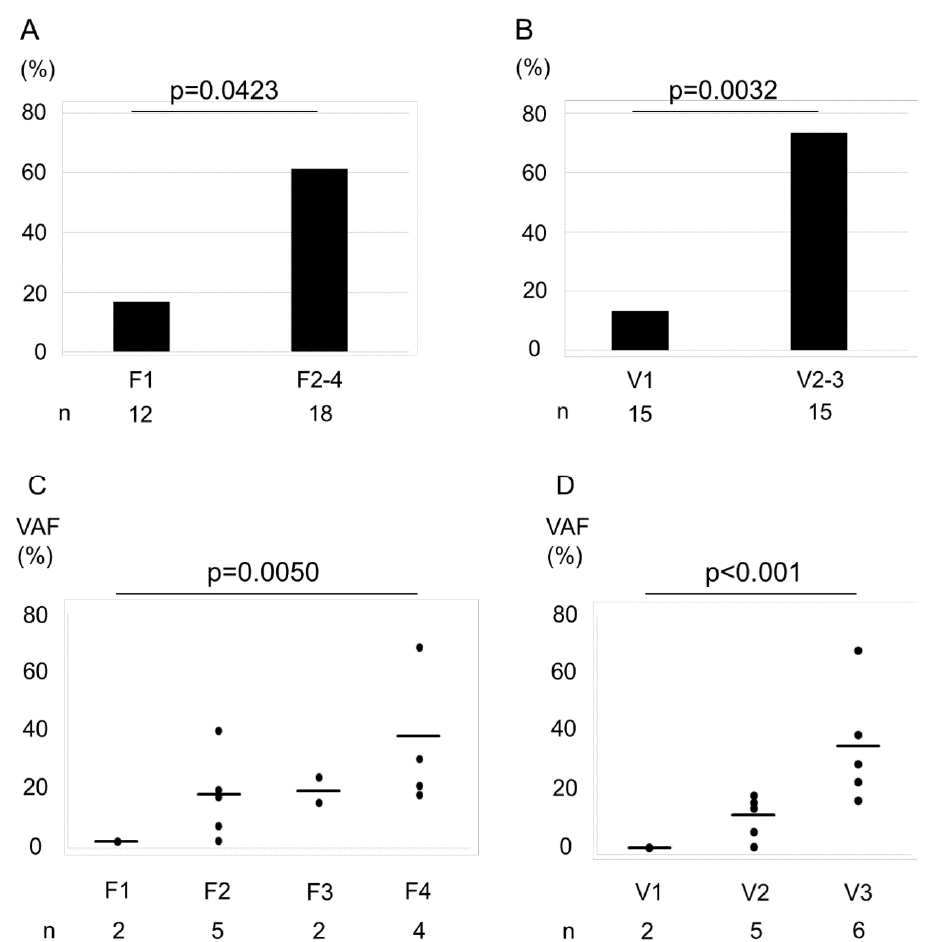
Figure 2. Association between the percentage of cases with a gene mutation and F–V-factor scores. Bar graphs represent the percentage of cases with a gene mutation by F factor score ( A ) and V-factor score ( B ). The rate of genetic mutations of F2–F4 was higher than F1 (A). The rate of genetic mutations of V2–V3 was higher than V1 ( B ). Statistical significance was assessed using χ 2 test. The variant allele frequencies (VAFs) increased with increasing F- and V-factor scores ( C , F factor; D , V-factor). Horizontal bars indicate the mean. Increasing trends were analyzed using the Jonckheere–Terpstra trend test. VAFs were plotted only for specimens with a confirmed gene mutation.